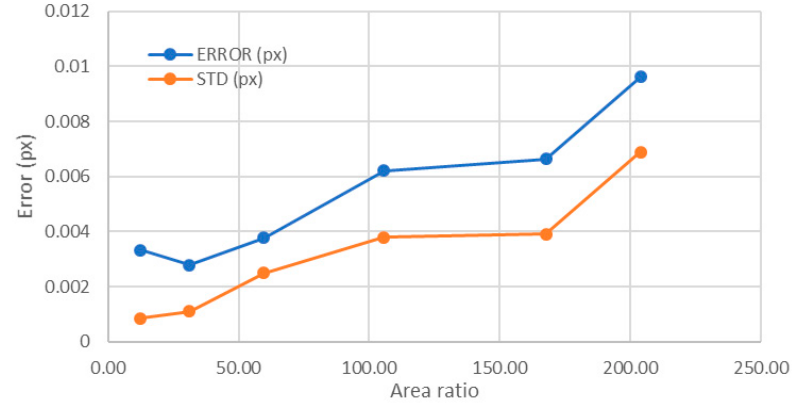
Figure 15. Influence of the area ratio for a point radius of 25 px (all having 256 levels).